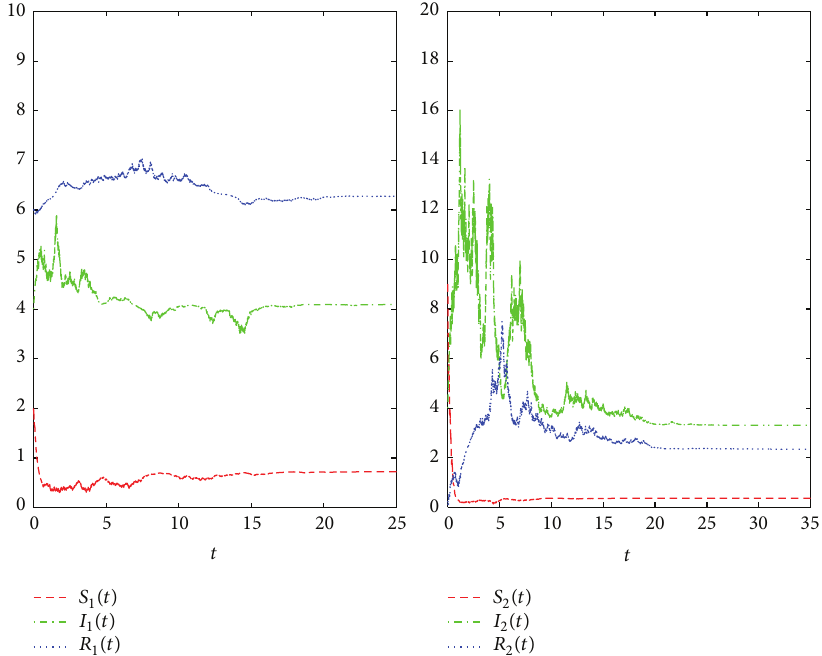
Figure 2: Stochastic trajectories of SIRS model (12) for 𝜎 11 = 0.4 , 𝜎 21 = 0.73 , 𝜎 31 = 0.45 , 𝜎 12 = 0.5 , 𝜎 22 = 0.67 , 𝜎 32 = 0.5 , and Δ𝑡 = 10 −3